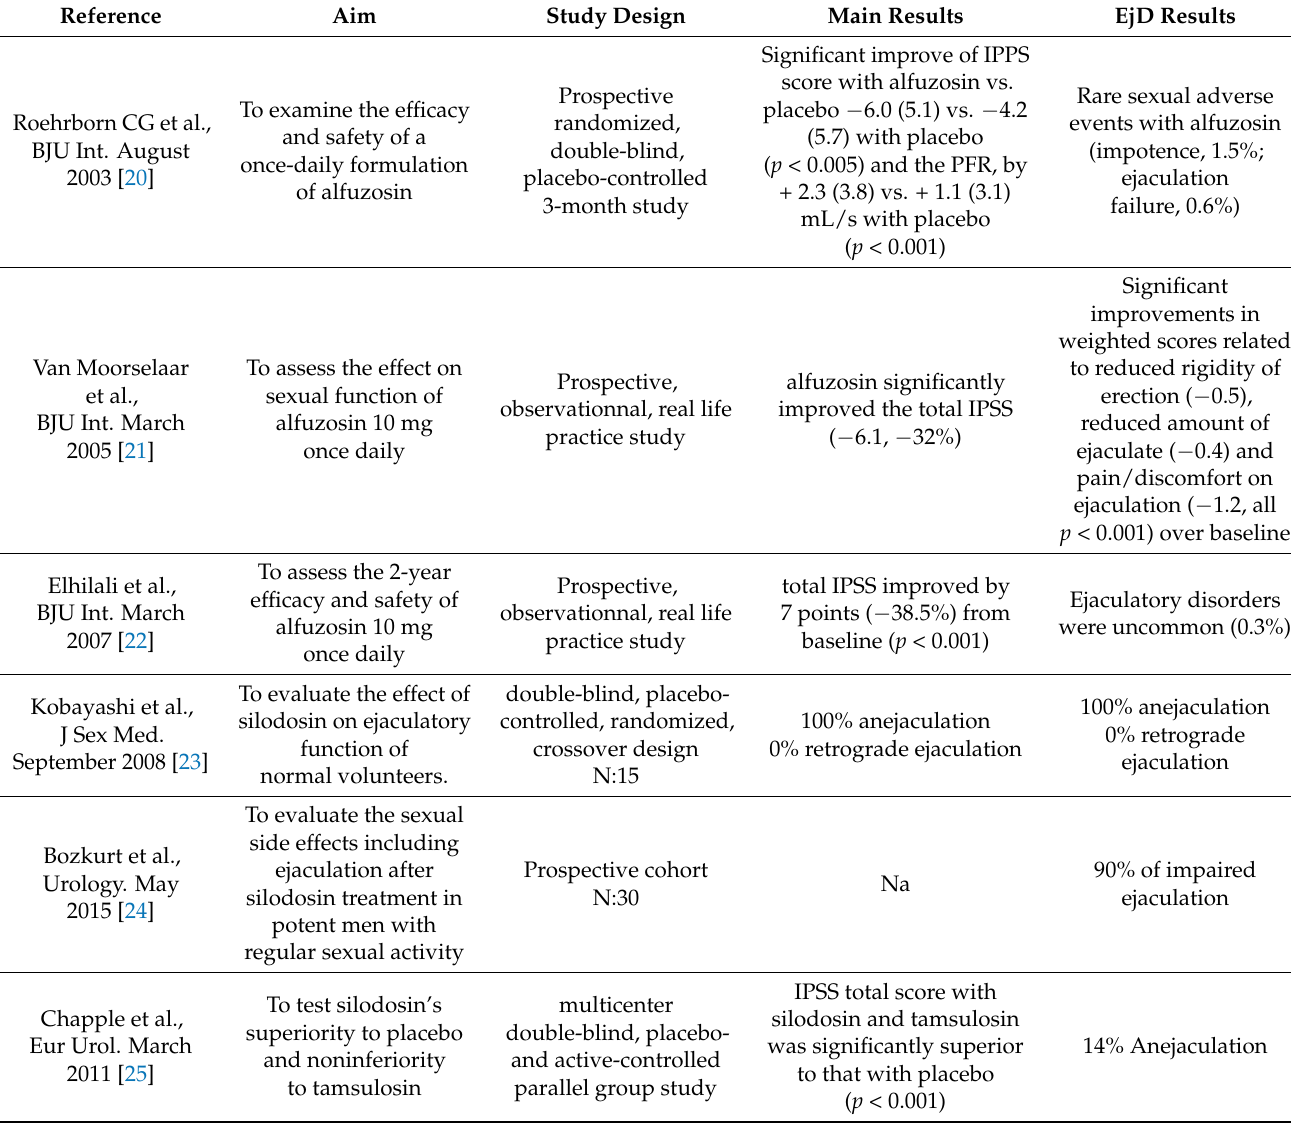
Table 2. Impact of unselective and selective alpha-blockers on the ejaculatory